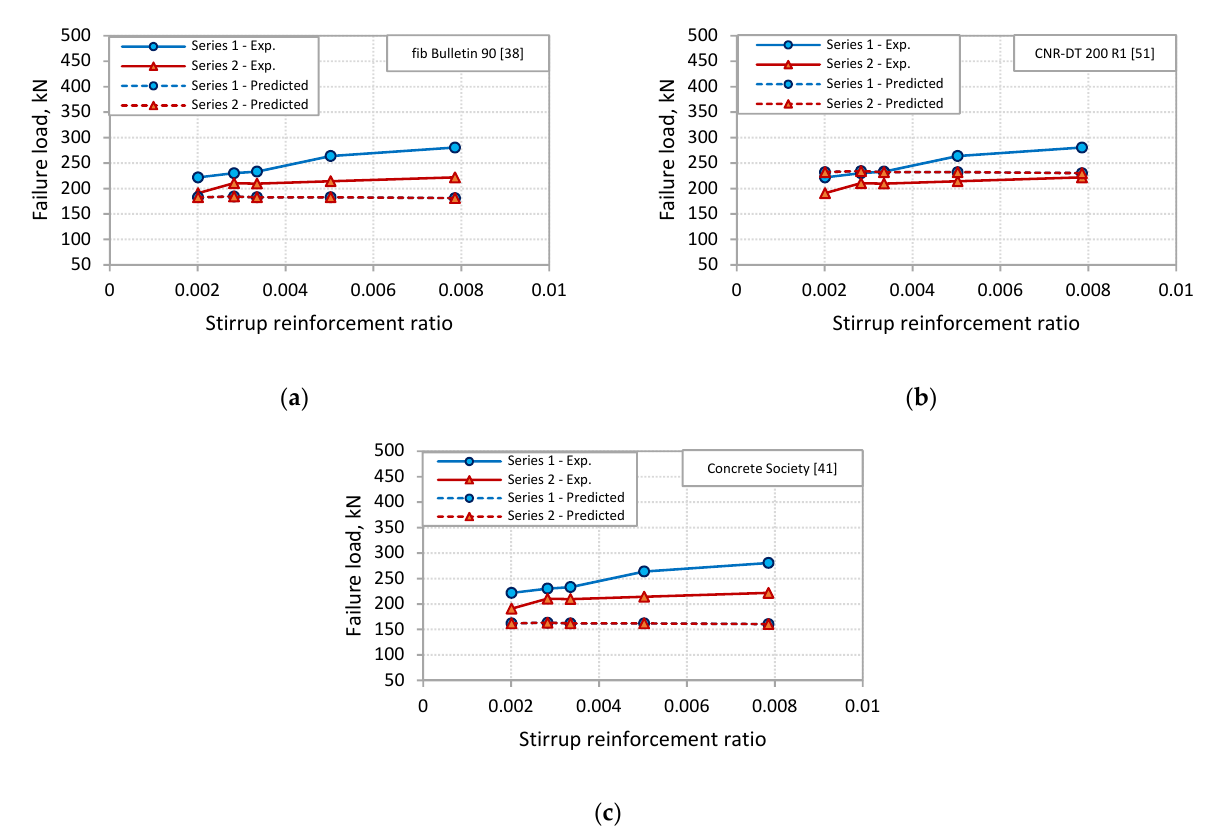
Figure 13. Comparisons of experimental versus predicted values for shear-based models: ( a ) El-Sayed et al. [14]; ( b ) Al- Ghrery et al. [15]; ( c ) fib Bulletin 90 [38]; ( d ) ACI 440.2R [39]; ( e ) AS 5100.8 [40]; ( f ) Concrete Society [41]; ( g ) Teng and Yao [21]; ( h ) Colotti et al. [37]; ( i ) Smith and Teng [19]; ( j ) Ahmed and Van Germert [36]; ( k ) Jansze [35]; ( l ) Oehler [34].